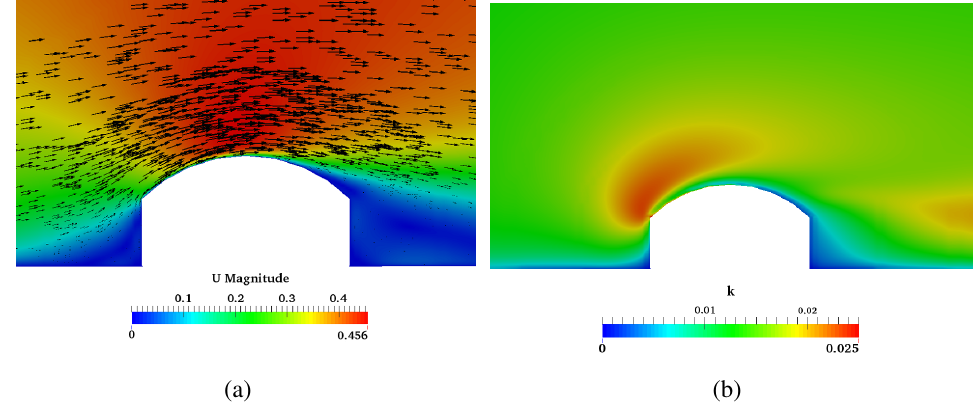
Figure 4. Vertical section at the center of the domain of the U and k fields around the validation building. ( a ) U field in m · s − 1 ; ( b ) k field in m 2 · s − 1